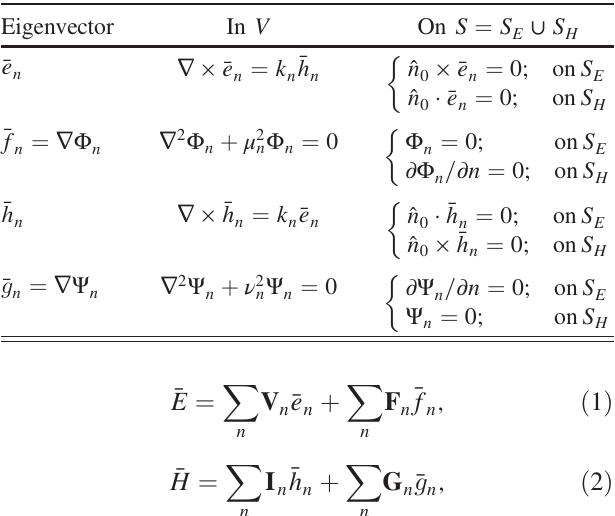
TABLE I. Eigenvector equations. Eigenvector